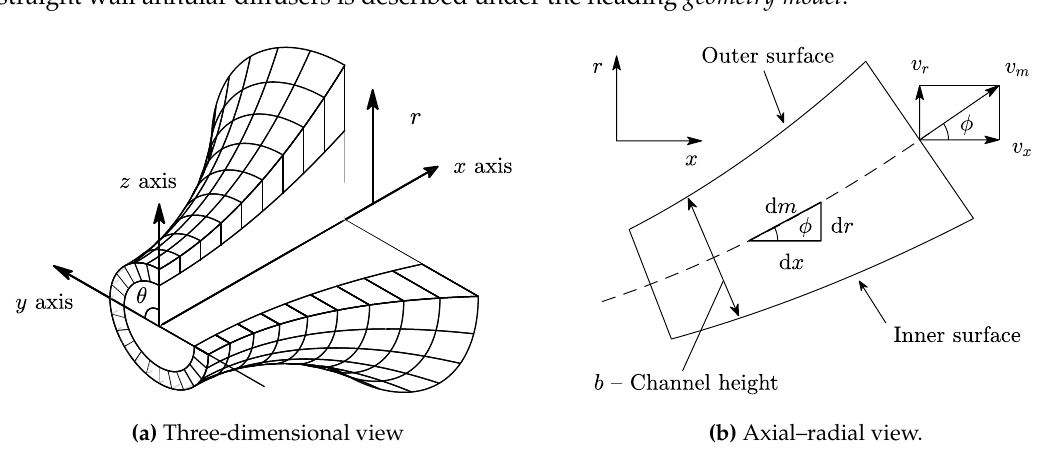
Figure 1. Geometry of a general annular